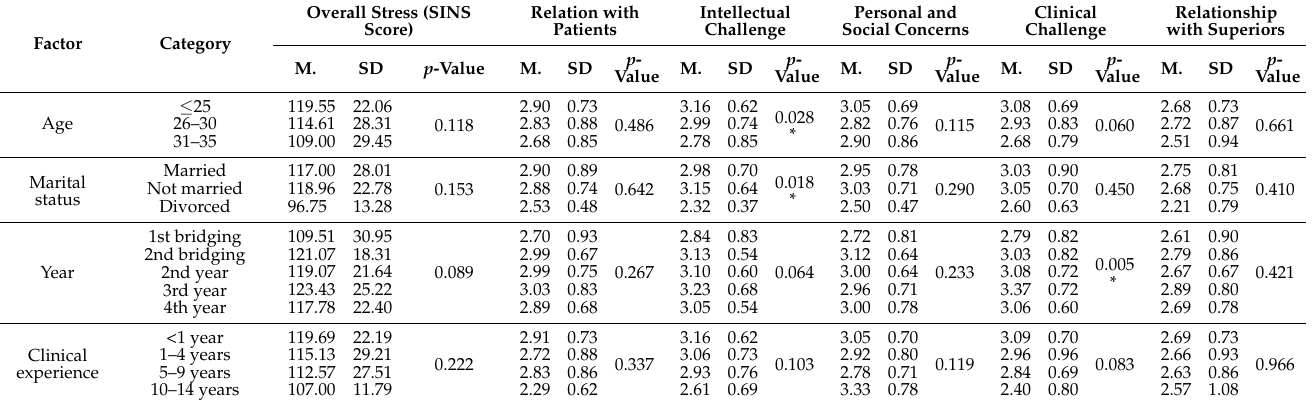
Table 2. Factors of stress among nursing students.